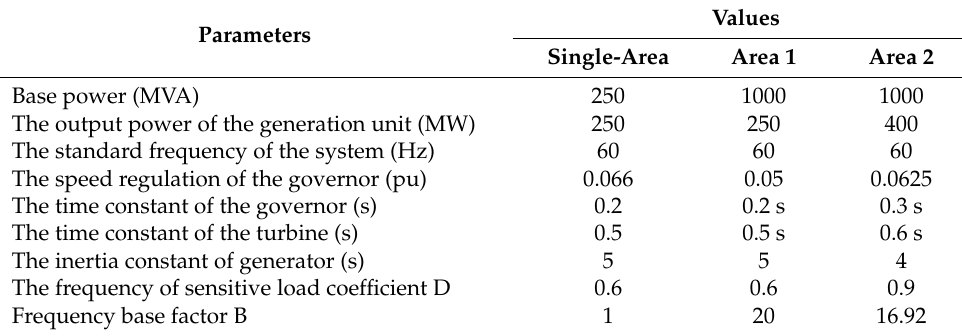
Table 6. Main parameters of the PSN for single-area and Table 4. A training strategy for on optimised ANN VS conventional ANN.